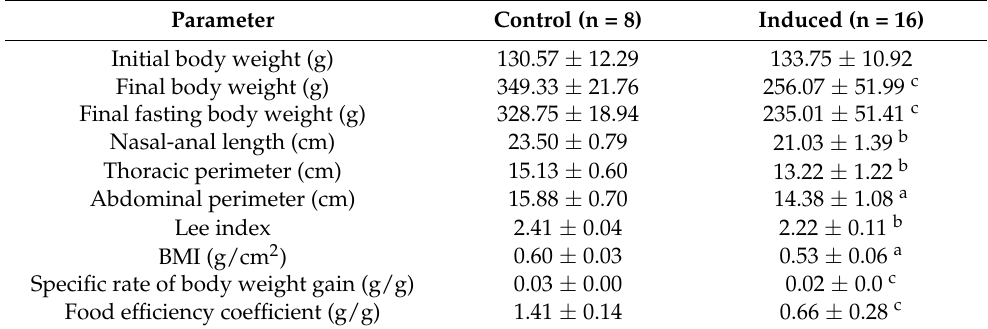
Table 5. Murinometric and nutritional parameters of animals from both groups control and